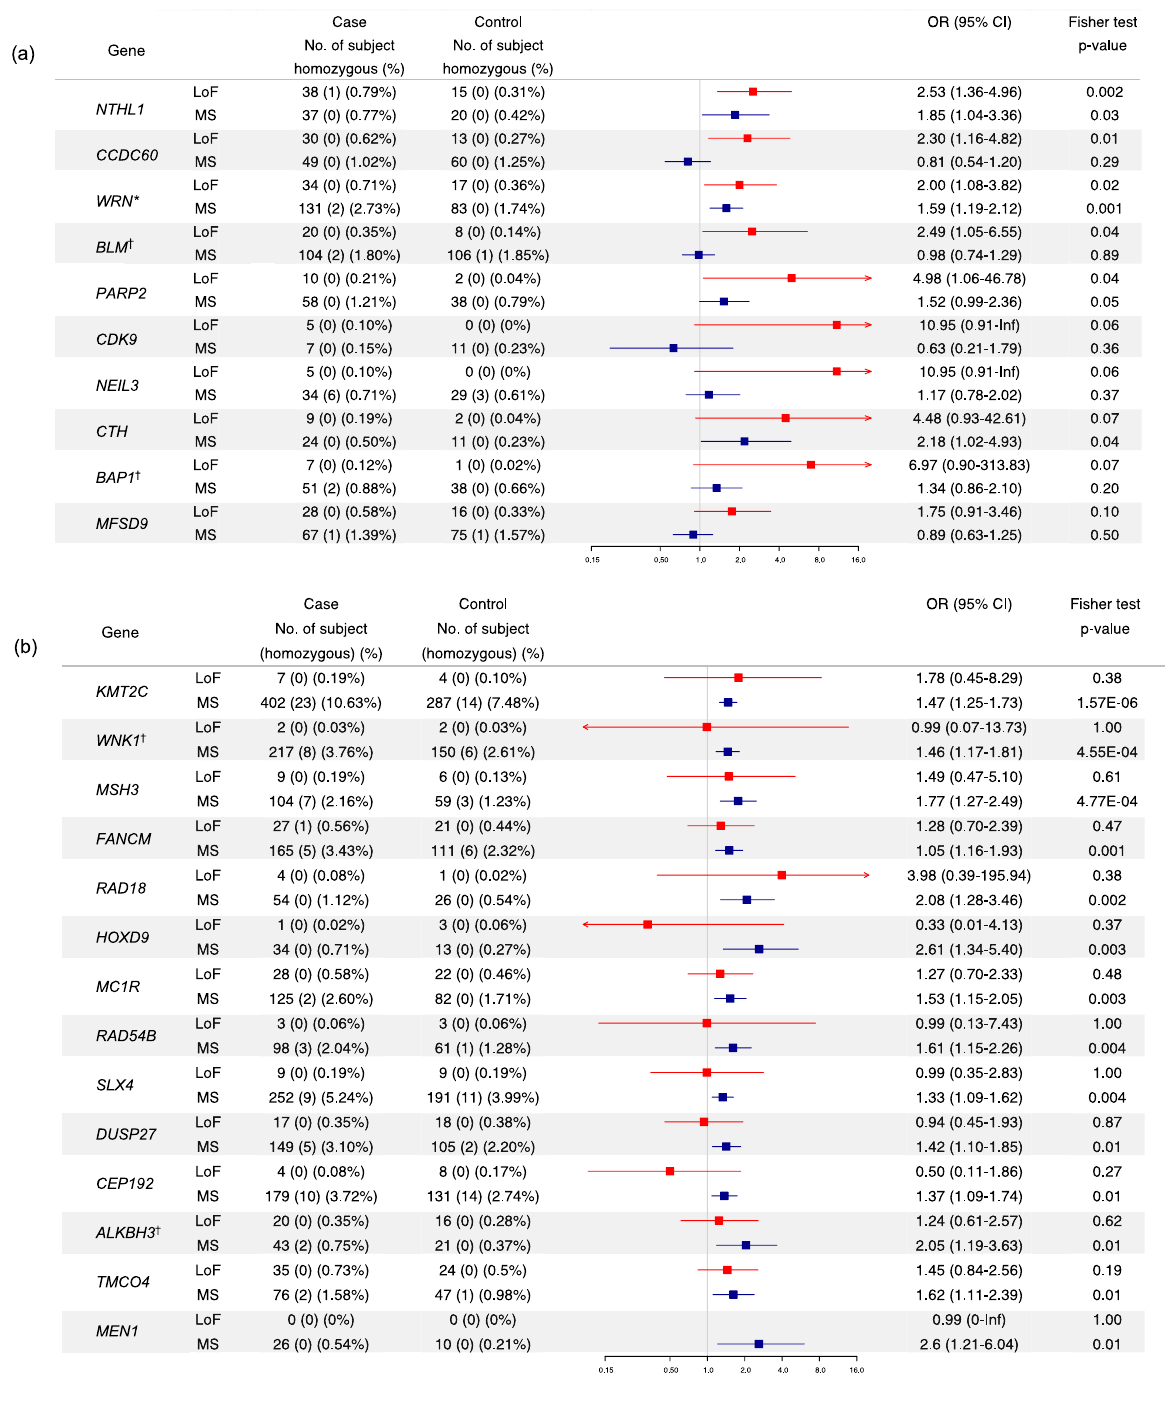
Fig. 4 Top candidate genes ranked by p -value according to the excess of a rare LoF and MS variants. a ( p ≤ 0.10, N = 10) and b ( p ≤ 0.011, N = 14). *One LoF variant in the gene WRN (p.Arg1406Ter) located in the last exon was detected in 21 cases and 11 controls. Although this variant is reported in gnomAD at high frequency in South Asian (MAF 0.0171 for South Asians compared to 0.0015 for Europeans), the identi fi ed carriers from this study are all of European origin except for one South Asian. BLM, BAP1, WNK1 and ALKBH3 were sequenced in 5770 cases and 5741 controls, and KMT2C was sequenced in 3780 cases and 3839 controls. The remaining genes were sequenced in 4807 cases and 4782